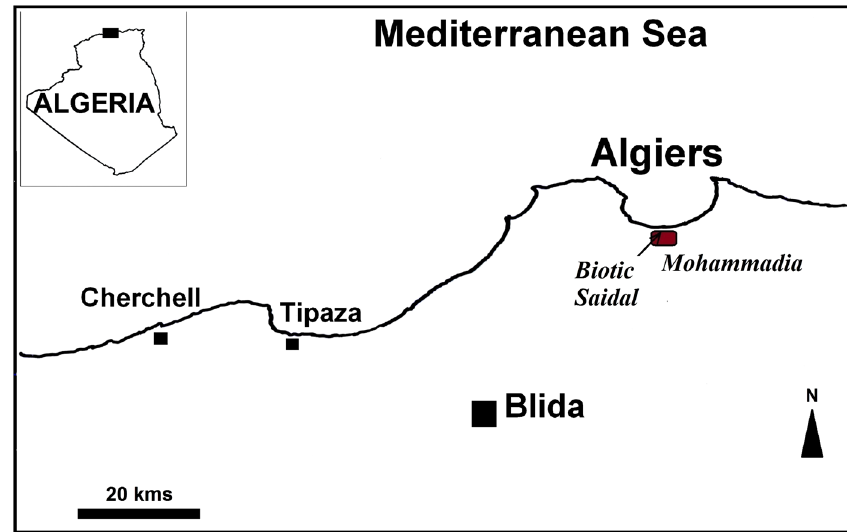
Fig. 1 Location of the Biotic Saidal (Bellevue, El Harrach,